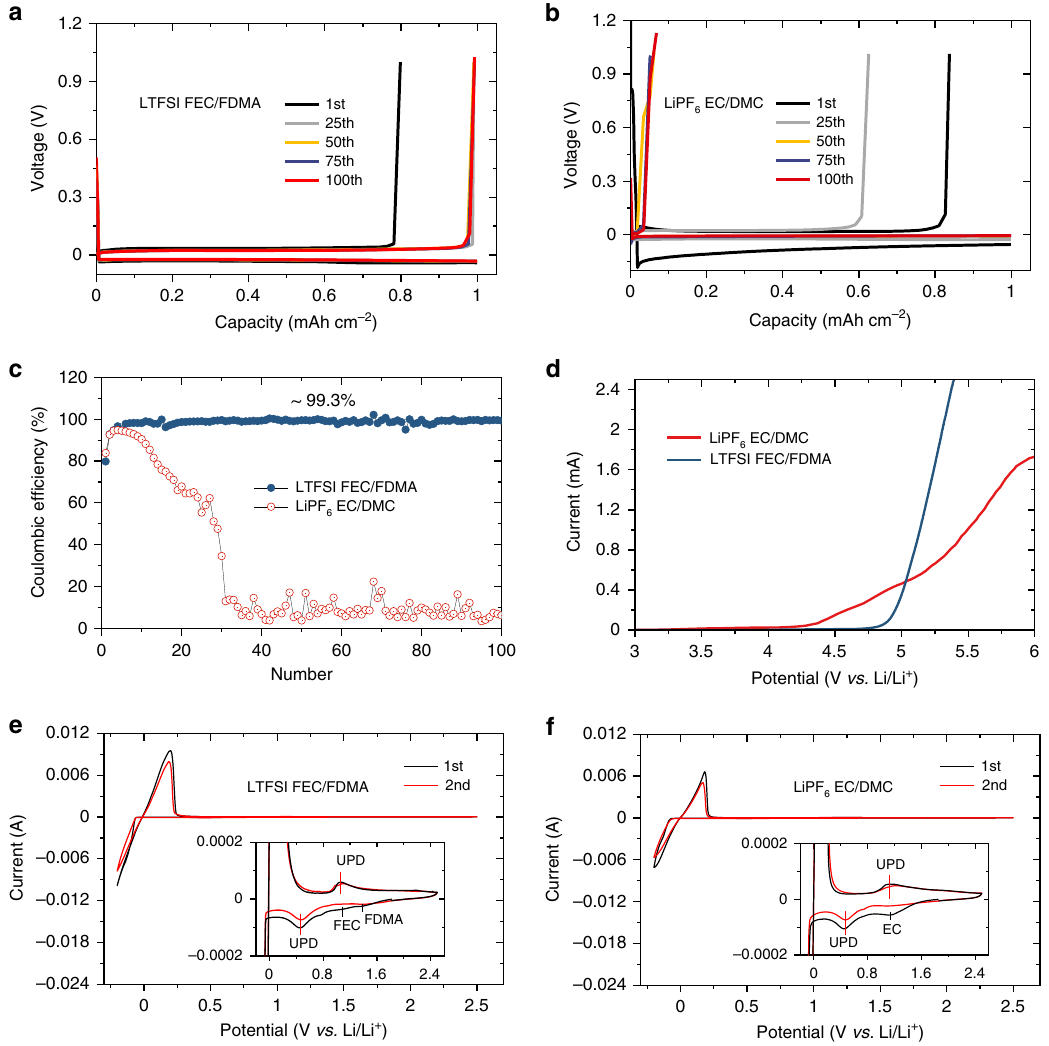
Fig. 2 Electrochemical properties of the electrolytes. a , b Voltage pro fi les for Li plating/stripping on a Cu working electrode cycled in 1 M LiTFSI-FEC/ FDMA and 1 M LiPF 6 -EC/DMC at a current density of 1 mA cm − 2 . c Li plating/stripping Coulombic ef fi ciency in Li||Cu cells using different electrolytes. Li was electrodeposited at 1 mA cm − 2 to a total capacity of 1 mAh cm − 2 followed by stripping to a cut-off voltage of 1.0 V vs. Li + /Li. d Positive linear sweep voltammograms (LSV) sweep to gauge the oxidation stabilities of the different electrolytes as evaluated on Li||stainless-steel cells at a scanning rate of 5 mV s − 1 . e , f Cyclic voltammetry (CV) curves of Li||Cu cells in 1 M LiTFSI-FEC/FDMA and 1 M LiPF 6 -EC/DMC electrolytes at a scanning rate of 1 mV s − 1 . The insets show the enlarged view